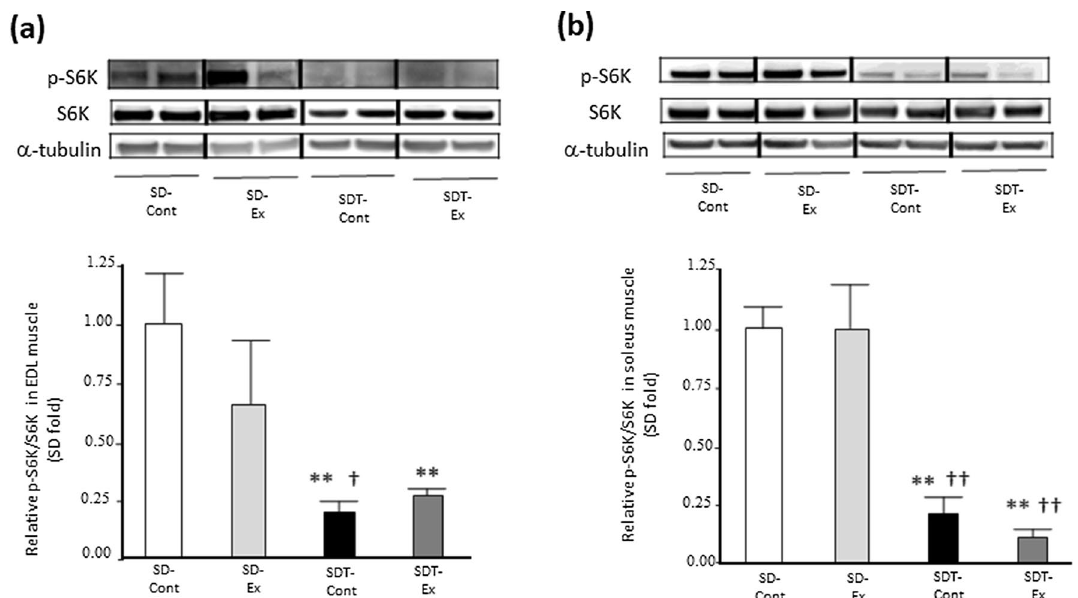
Fig. 2 Protein expression of phosphorylated ribosomal protein S6 kinase beta‑1 (S6K) related to protein synthesis in the extensor digitorum longus (EDL) and soleus muscles. Protein expression of phosphorylated ribosomal protein S6 kinase beta‑1 (S6K) ( a : EDL, b : soleus) in the EDL and soleus muscles as determined by western blot analysis. Entire images of western blotting are shown in online Additional file 1: Fig S3. Values are presented as mean standard error of the mean. SD‑Cont group, n ± SD‑Cont group; † P < 0.05 and †† P < 0.01 vs. the SD‑Ex